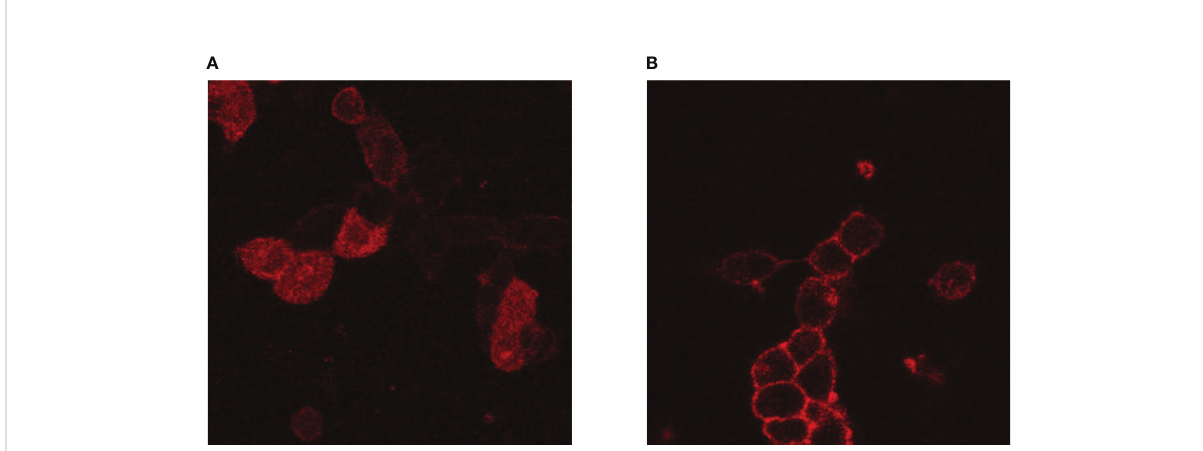
FIGURE 2 Comparison of IGF1R antibodies in fl uorescent microscopy. HEK-TSHR cells were fi xed with 4% paraformaldehyde and incubated with 5 µg/mL IGF1R antibodies overnight at 4°C. An anti-mouse-Alexa-647 secondary antibody was used at a 1:20,000 dilution for 30 minutes at room temperature. IGF1R (red) were detected using IGF1R antibody clone 1H7 (A) or clone a IR3 (B) . Even though both 1H7 and a IR3 recognize IGF1R in live cells, cell- fi xation may change the antibody epitope on IGF1R, results in non-speci fi c binding of 1H7. This did not occur for a IR3, which showed membrane-speci fi c fl uorescence. However, this cannot be predicted, and every antibody must be veri fi ed prior to